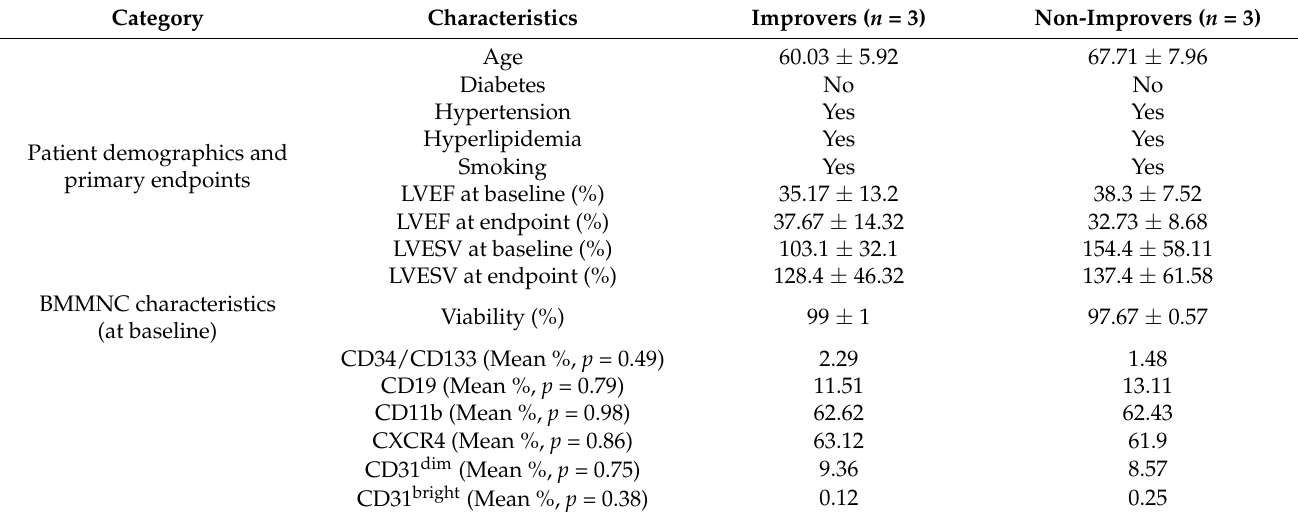
Table 3. Patient and BMMNC characteristics from samples selected for MSC